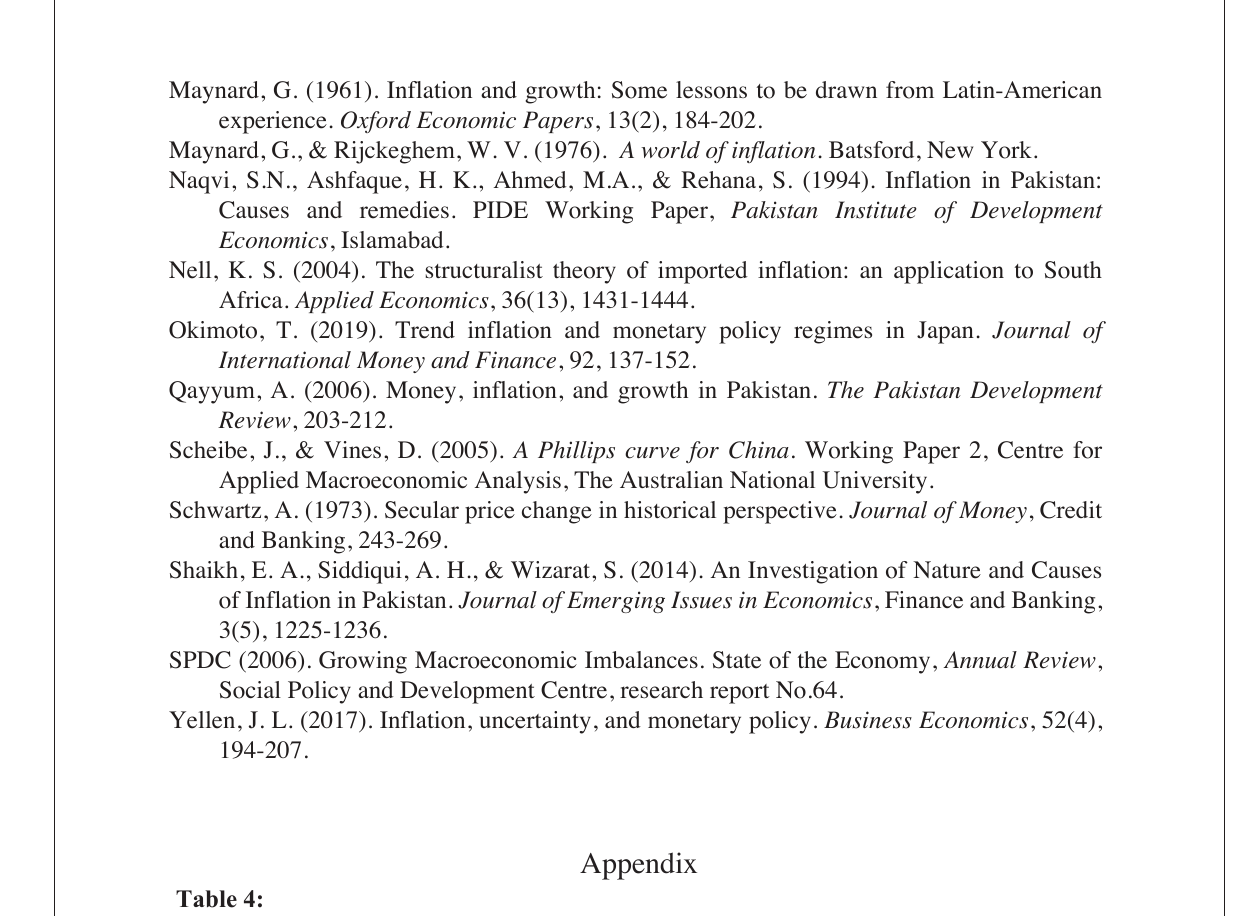
Detail of Abbreviation and Data